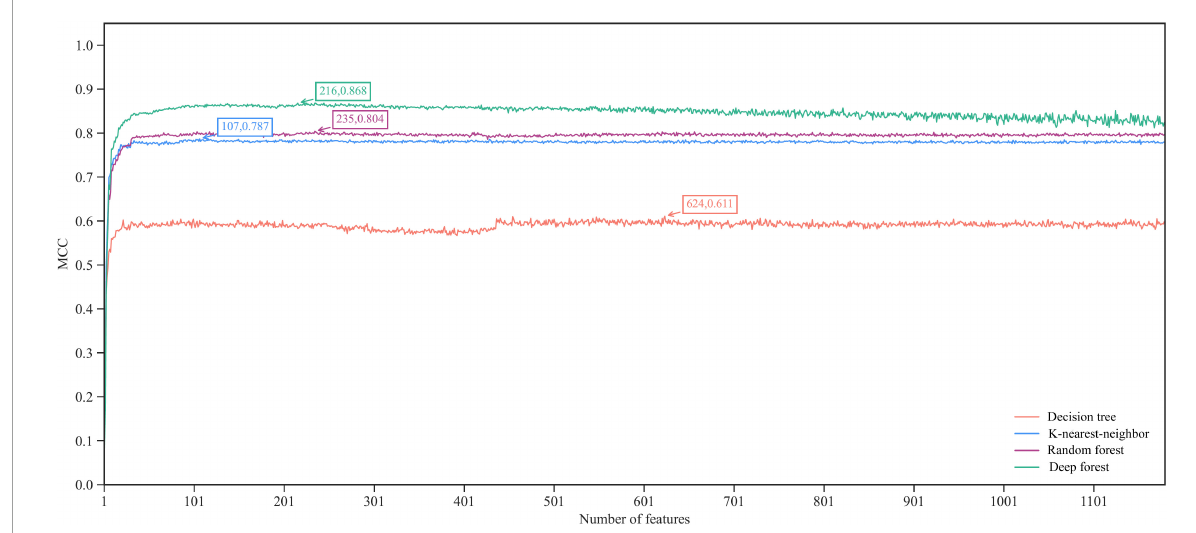
FIGURE2 The IFS curves of four classification algorithms in terms of MCC. The highest MCC values of four algorithms are marked. The deep forest yields the highest MCC of 0.868 when top 216 features in the mRMR feature list are used.